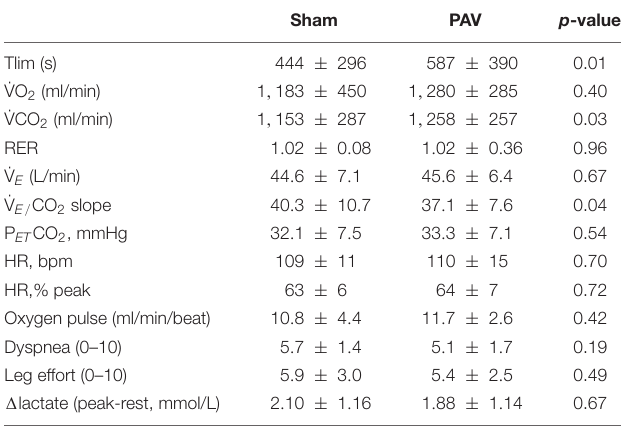
TABLE 2 | Main physiological responses at the time of constant work rate exercise tolerance (Tlim) after sham or proportional assist ventilation ( N = 10). Sham PAV